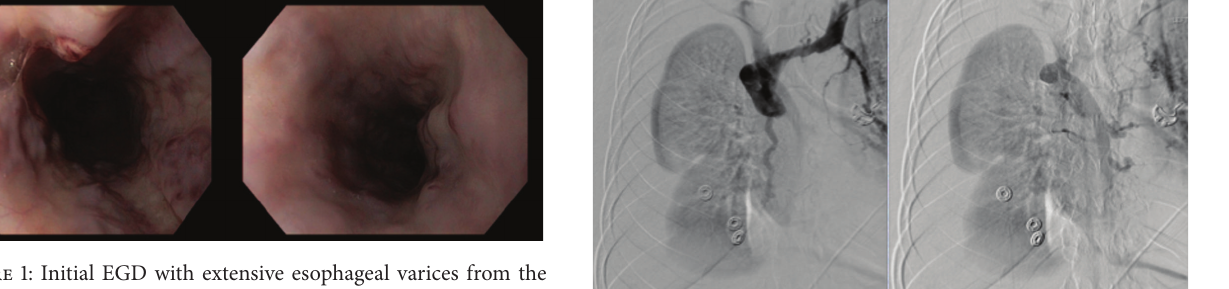
Figure 2: SVC venogram with occluded SVC and extensive collat- eral vessels.